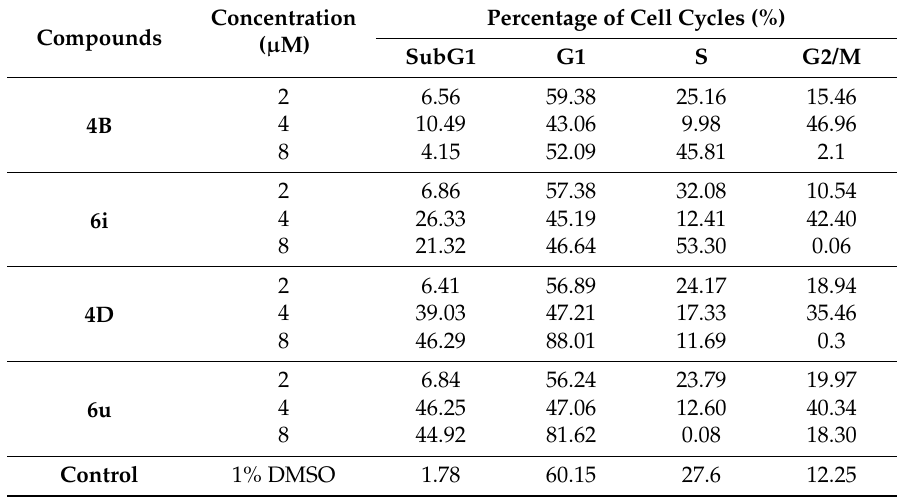
Figure 2. The cell cycle was detected by flow cytometry using PI single staining. A549 cells were treated with 4B , 6i , 4D , and 6u at 2, 4, and 8 µ M for 48 h, and then stained with PI for 30 min at 37 ◦ C. The proportions of cells containing different DNA content were analyzed by FCS Express 5.0 (De Novo Software, Thornhill, Canada). Table 2. The percentage of cell cycles of A549 cells at indicated compound concentrations ( 4B , 6i , 4D , and 6u at 2, 4, and 8 µ